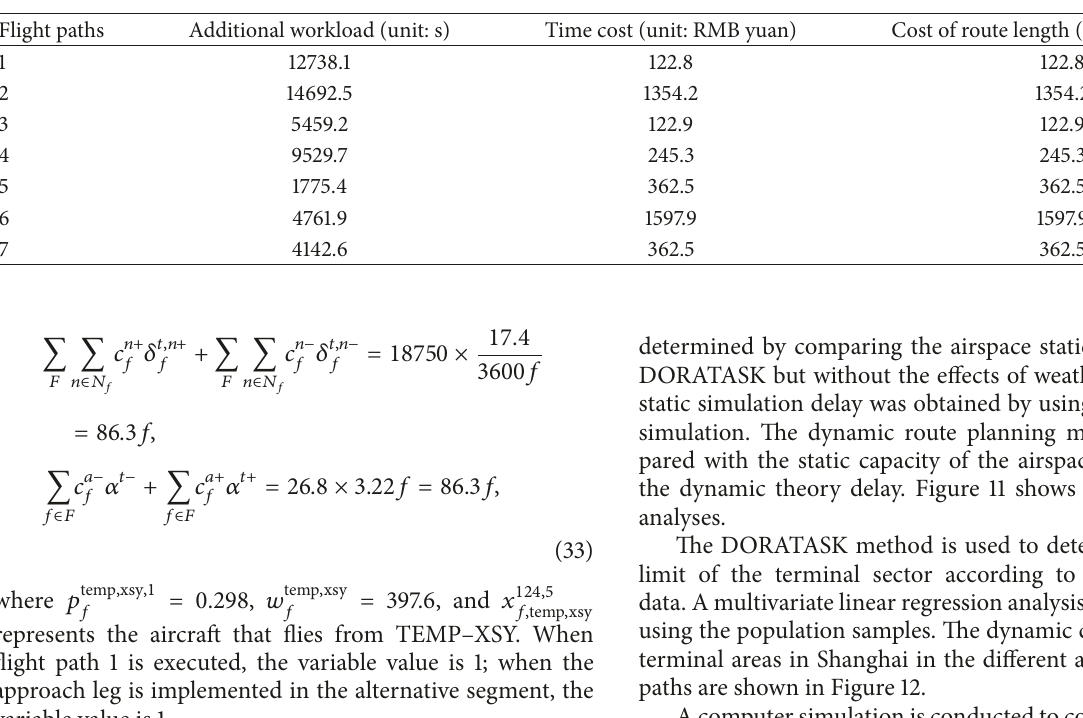
Table 7: Comparative analysis of various flight